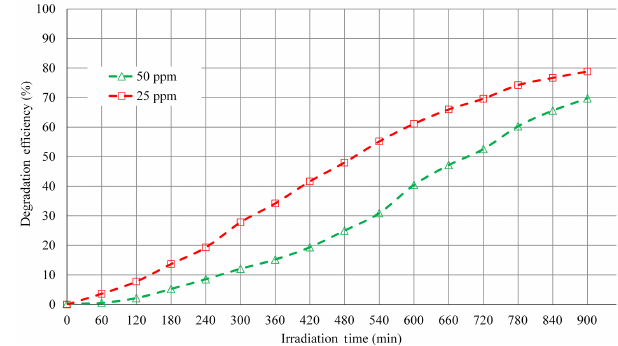
Figure 6. The effect of the BPA initial concentration on the progress of photodegradation.